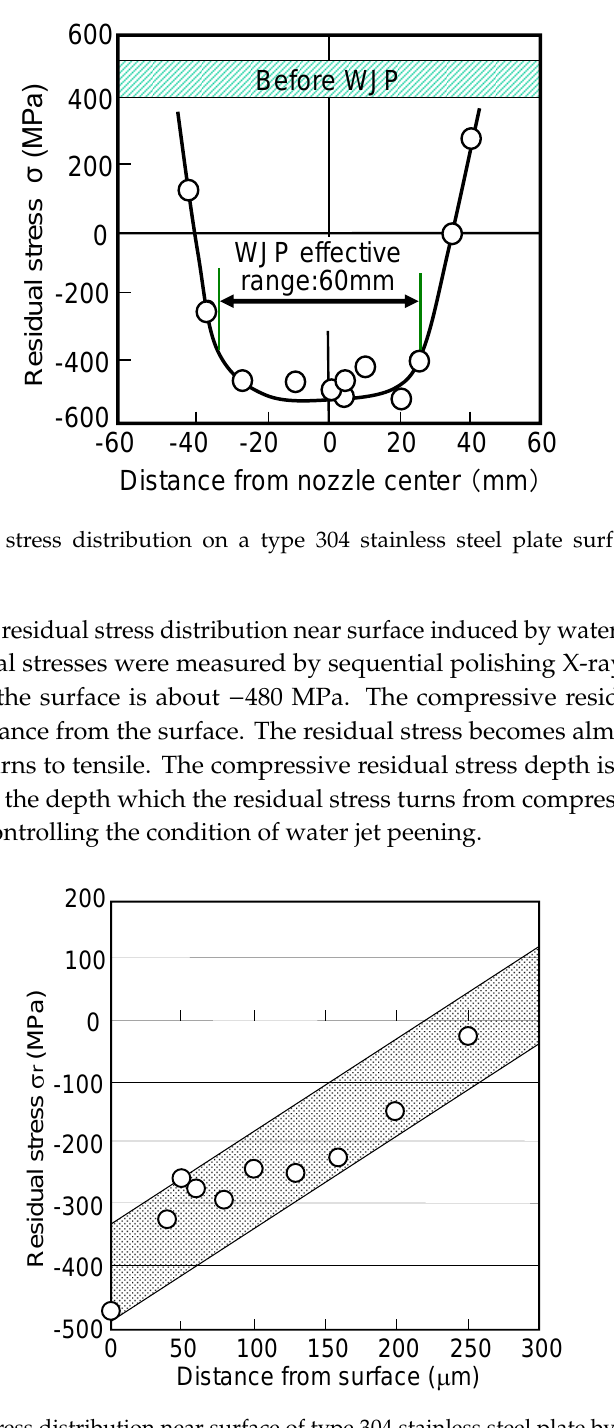
Figure 5. Residual stress distribution near surface of type 304 stainless steel plate by water jet peening measured by sequential polishing X-ray diffraction method.